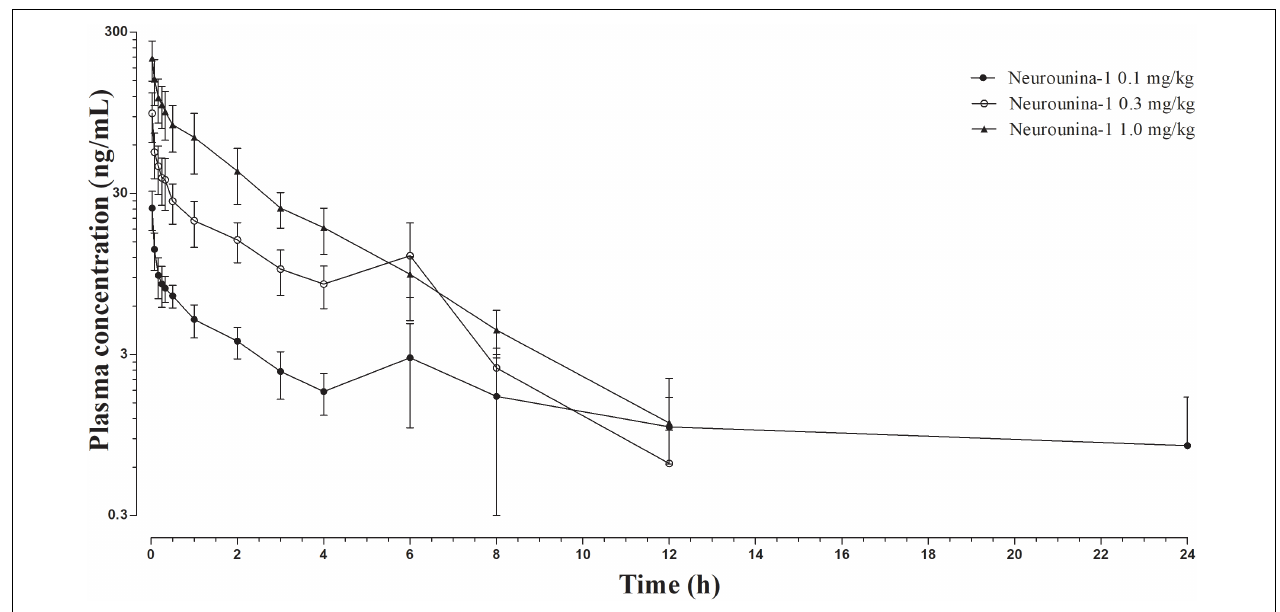
FIGURE 3 | Neurounina-1 plasma concentration vs. time profile obtained after a single intravenous administration of 0.1, 0.3, and 1 mg/kg of neurounina-1 to beagle dogs ( n = 5). Data are expressed as mean and standard deviation.